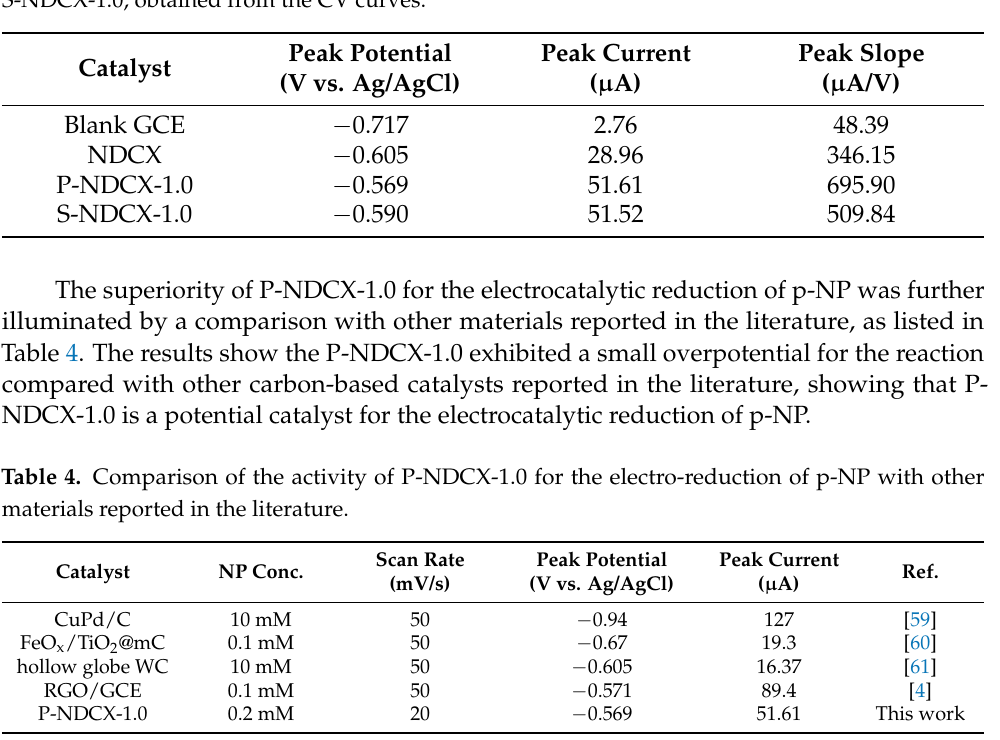
Table 3. The overpotential, peak current, and peak slope of blank GCE, NDCX, P-NDCX-1.0, and S-NDCX-1.0, obtained from the CV curves.